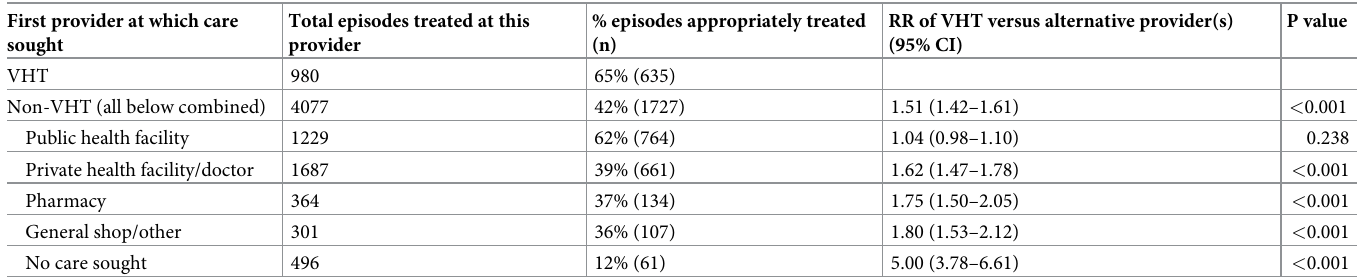
Table 5. Appropriate treatment of children with episodes of MDP by first provider where care was sought. Significance tests compare appropriate treatment rate at the VHT (‘exposure group’) versus other provider types (‘null group’) in turn. First provider at which care